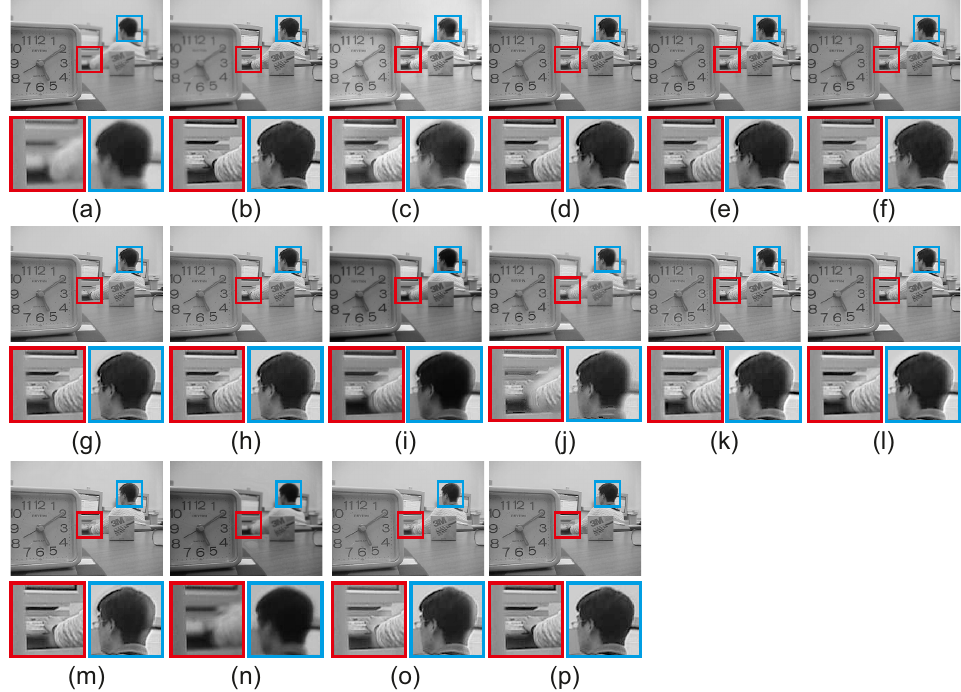
Figure 11. Fused results for the scene ‘Lab’ of the grayscale dataset [3]. ( a ) Source 1, ( b ) Source 2, ( c ) GBM [36], ( d ) NSCT [14], ( e ) ICA [11], ( f ) DCHWT [17], ( g ) ASR [12], ( h ) IFCNN